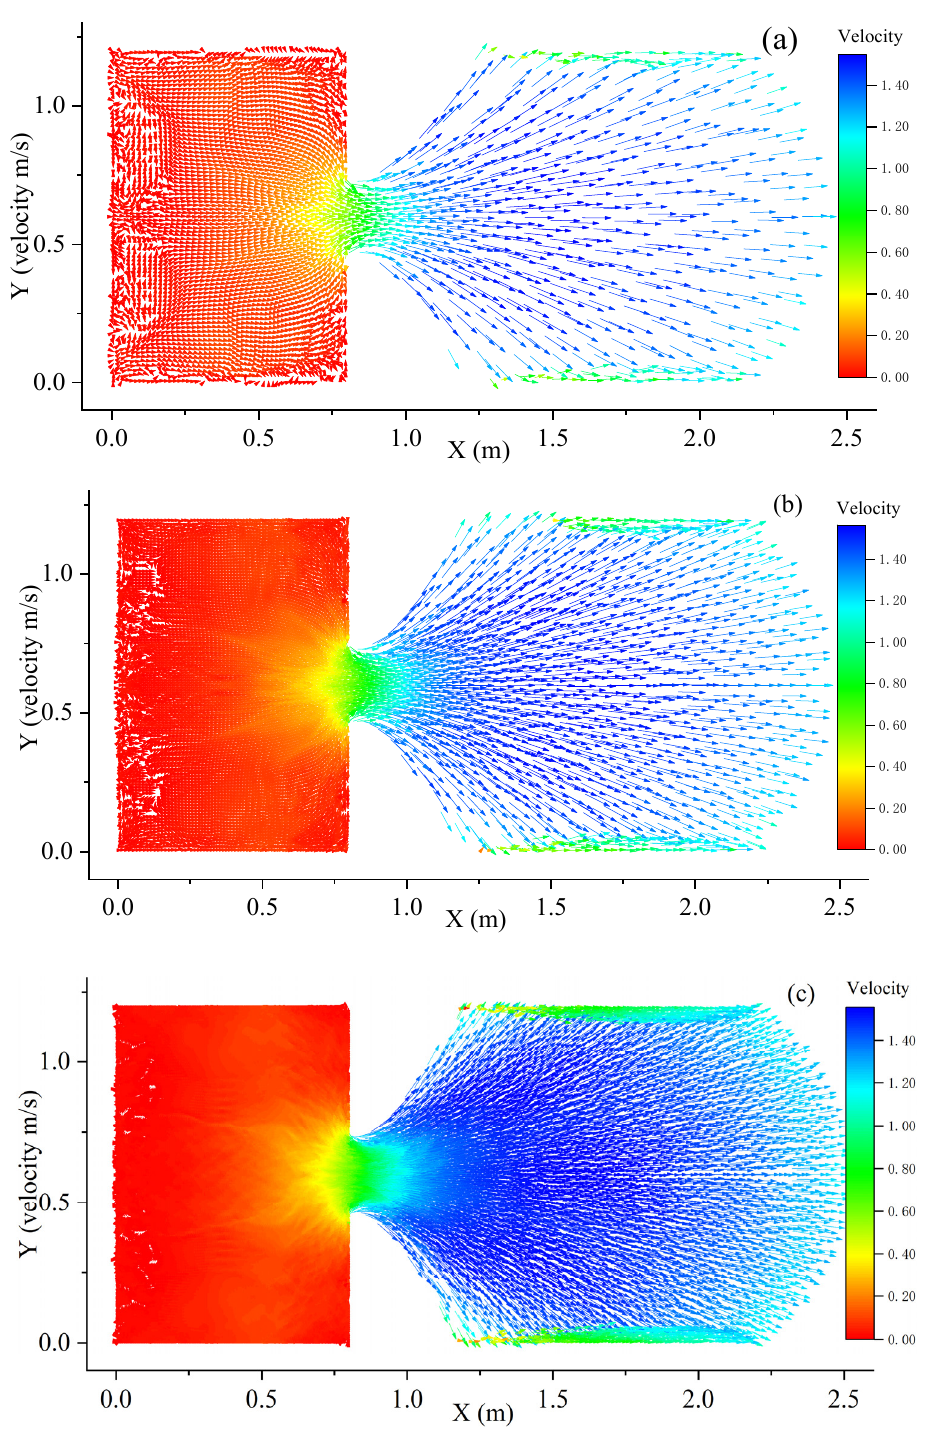
Figure 7. Results of 2-D Dry-Bed Dam Break with particle splitting at 1.2 s obtained from the simulations with: ( a ) 4374 particles; ( b ) 9801 particles; ( c ) 38,801 particles.